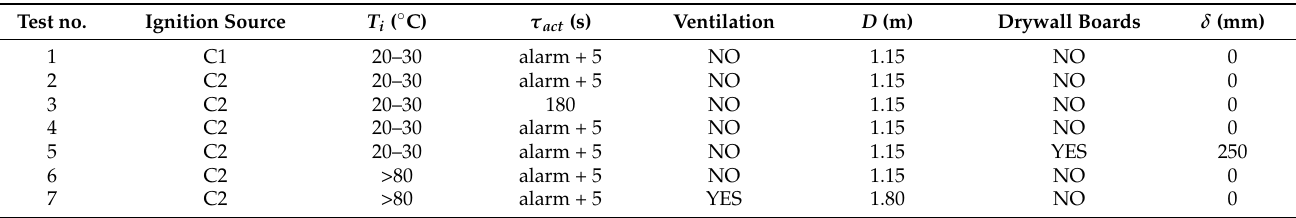
Table 2. Test matrix with experimental